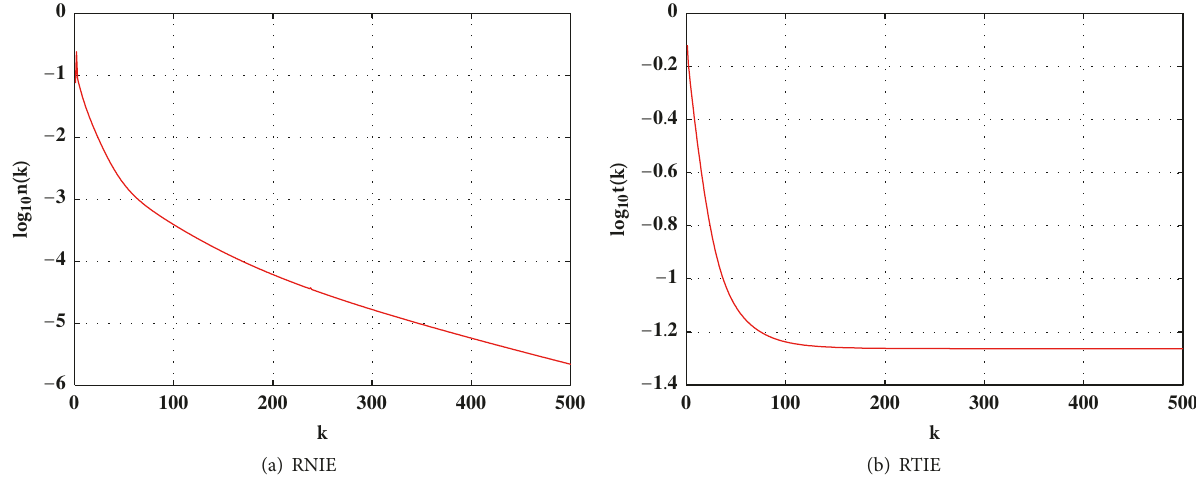
Figure 5: Convergence behavior of Algorithm 1. Table 1: PSNR | SSIM results on Lenna image with different missing ratios by different